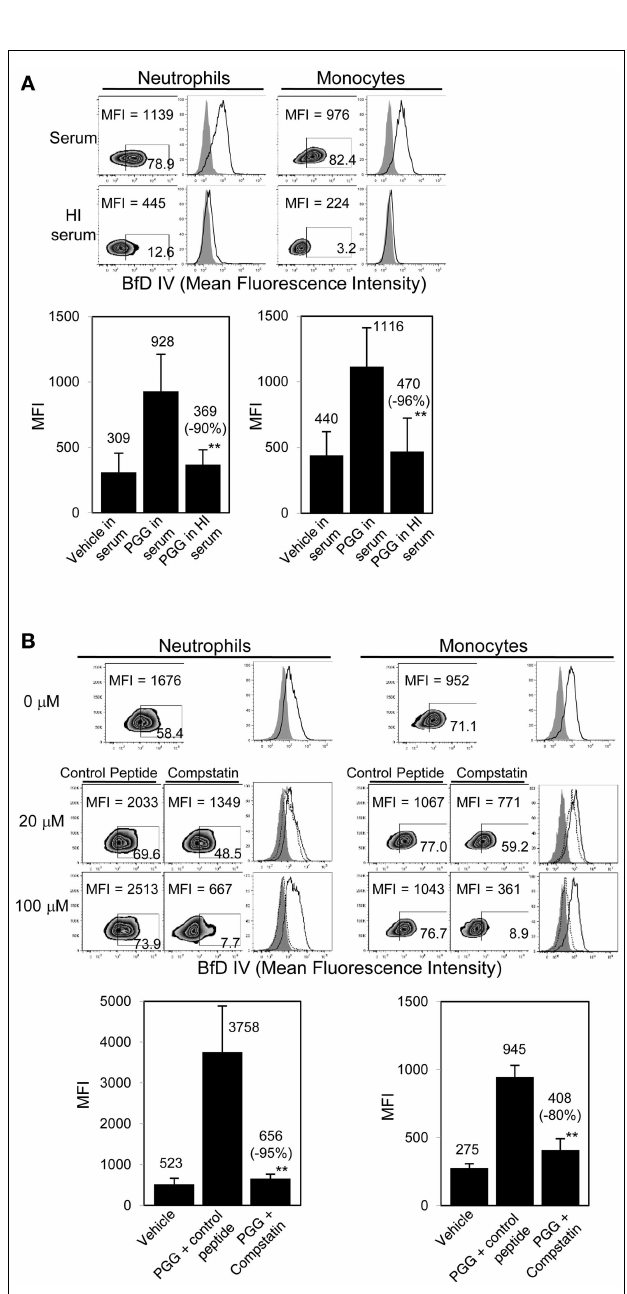
FIGURE 3 | Role of complement in binding of PGG β -glucan to human neutrophils and monocytes . (A) Binding of PGG β -glucan to human neutrophils and monocytes in 10% serum (upper row) was compared to binding in 10% HI serum (lower row). Histograms show PGG β -glucan binding (solid) in comparison to vehicle-control (gray filled). Bar represents mean MFI from five donors with percentage of inhibition indicated in parenthesis. ** p ≤ 0.05 compared to binding in serum. (B) Inhibitory effect of C3-inhibitor compstatin on PGG β -glucan binding in neutrophils and monocytes was measured and compared to that of control peptide-treated group. Histograms show PGG β -glucan binding in the presence of peptide control (solid) or compstatin (dotted) in comparison to vehicle-control (gray filled). Bar represents mean MFI with percentage of inhibition indicated in parenthesis. ** p ≤ 0.05 compared to binding in control peptide. Data shown are representative of at least three independent experiments performed with cells obtained from different